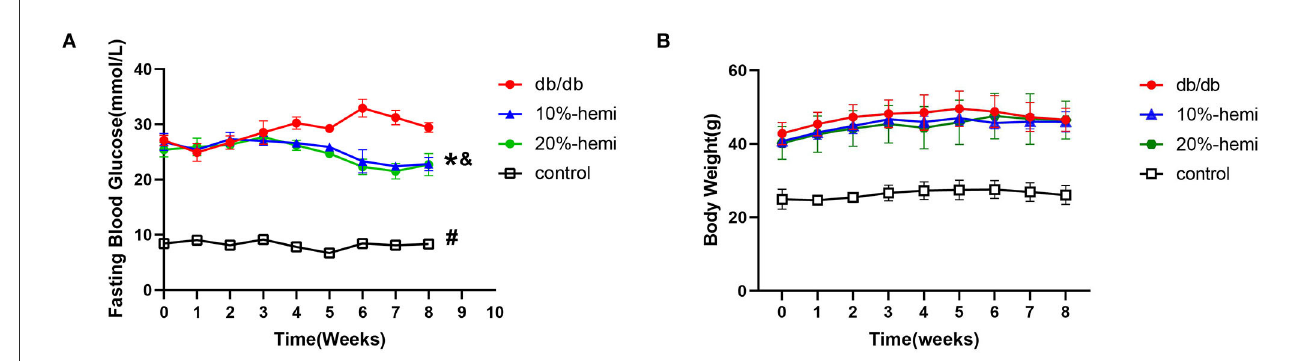
FIGURE1 Fasting blood glucose (A) and body weight (B) of the mice for the four groups (# db/db Vs. control, p < 0.05; *10%-hemi Vs. db/db, p < 0.05; & 20%-hemi Vs. db/db, p < 0.05).